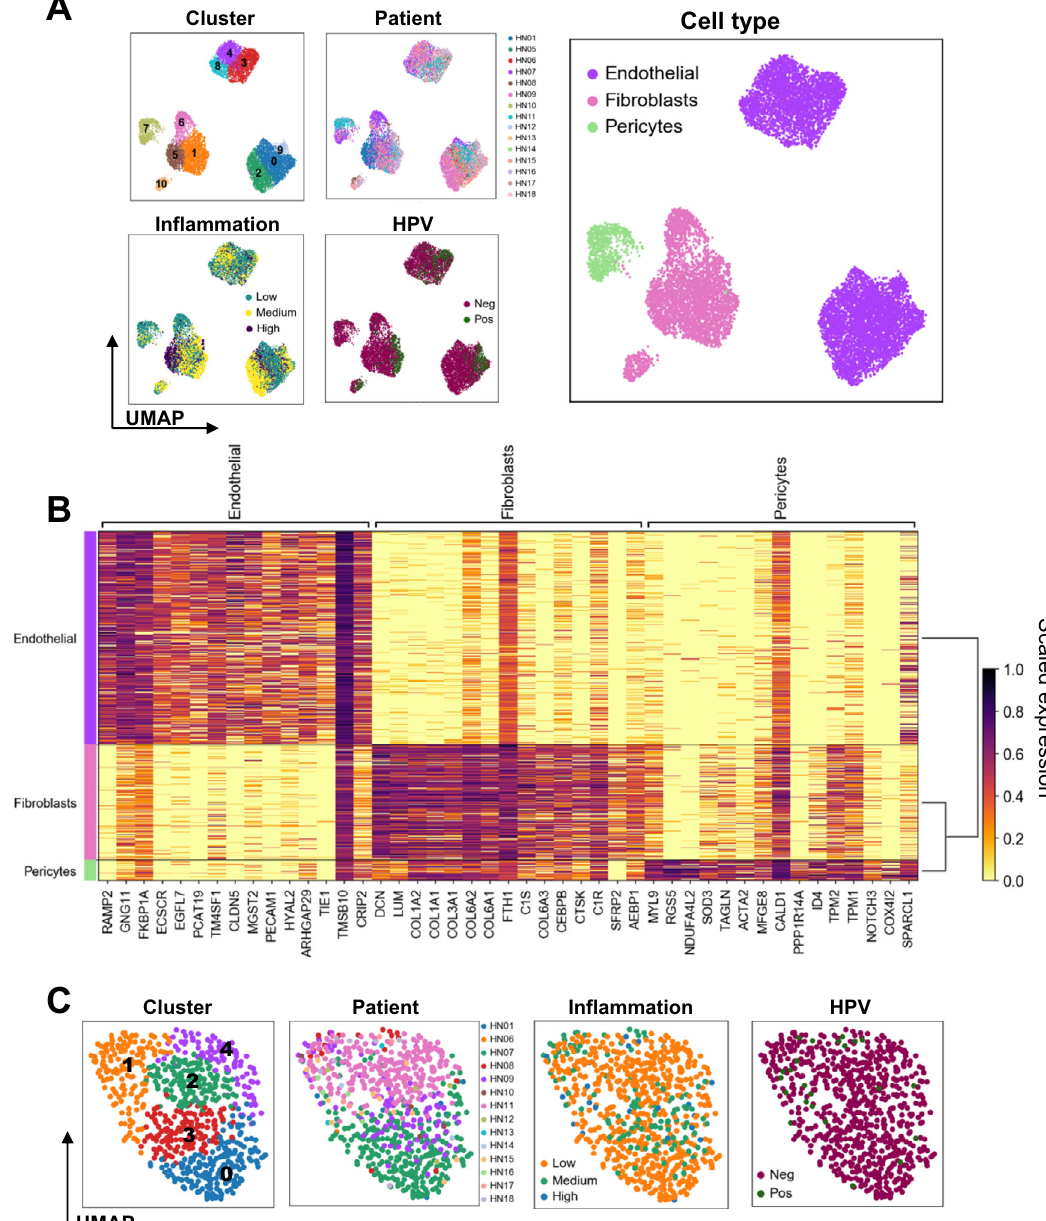
Fig. 4 Overview of stromal cells with a focus on pericytes. A Sub-clustering of 12,179 stromal cells (non-immune, non-epithelial cells; n = 15 patients; cluster 0 – 10) and visualization of relevant characteristics: patient contribution (HN01, HN05 – HN18), viral-status (HPV + vs. HPV – ), cell type (endothelial, fi broblasts, pericytes) and in fl ammation score (low, medium, high). B Heatmap showing top 10 genes characterizing each cluster (color scale depicts scaled gene expression). C Sub-clustering of pericytes (cluster 0 – 4) and visualization of relevant characteristics: patient contribution (HN01 – HN18), viral- status (HPV + vs. HPV – ), cell type (endothelial, fi broblasts, pericytes), and in fl ammation status (low, medium,